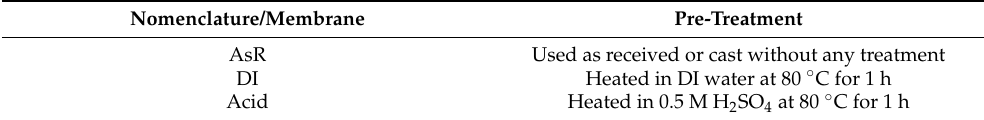
Table 1. Nomenclature, a brief description of pre-treatment